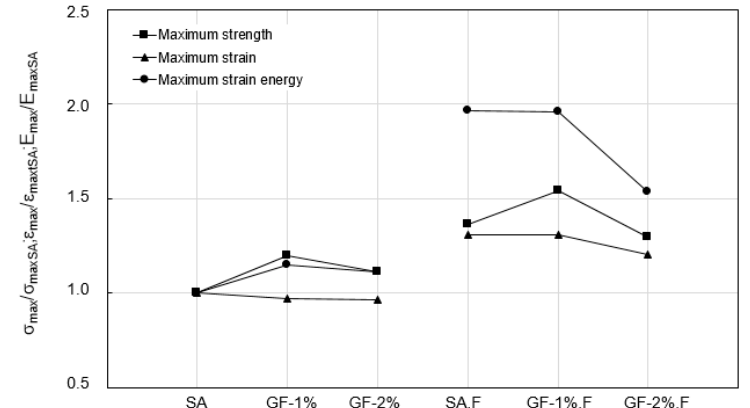
Figure 13. Evolution of the mean values associated with the maximum strengths and strains from compressive strength testing, in test pieces before and after direct fire testing.